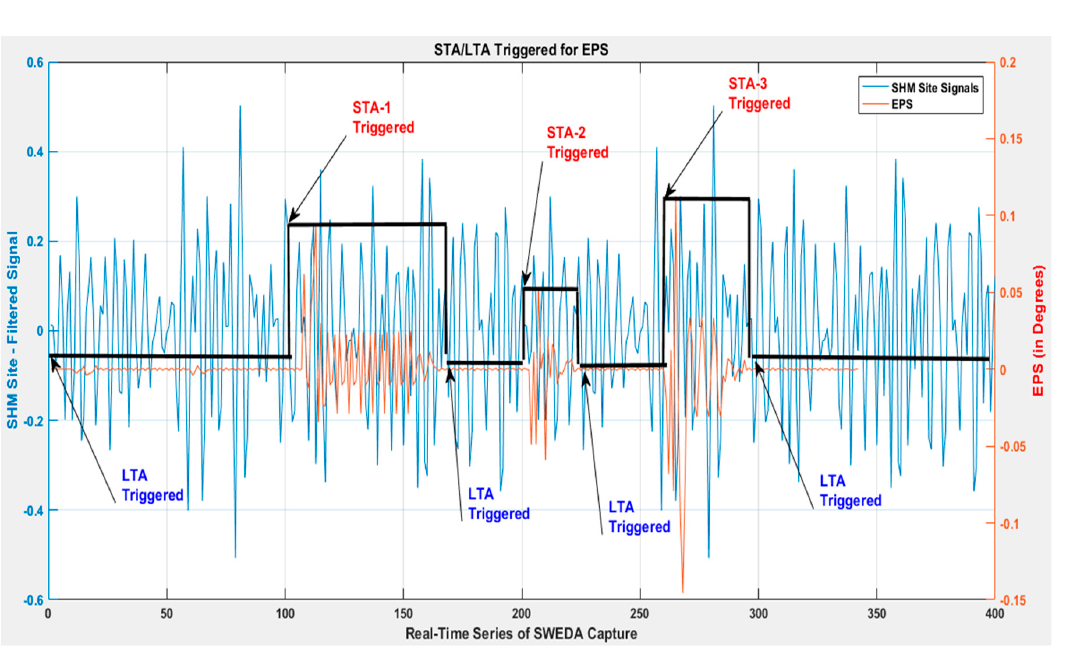
Figure 8. The automated triggering of short-time average over long-time average (STA/LTA) with SWEDA.